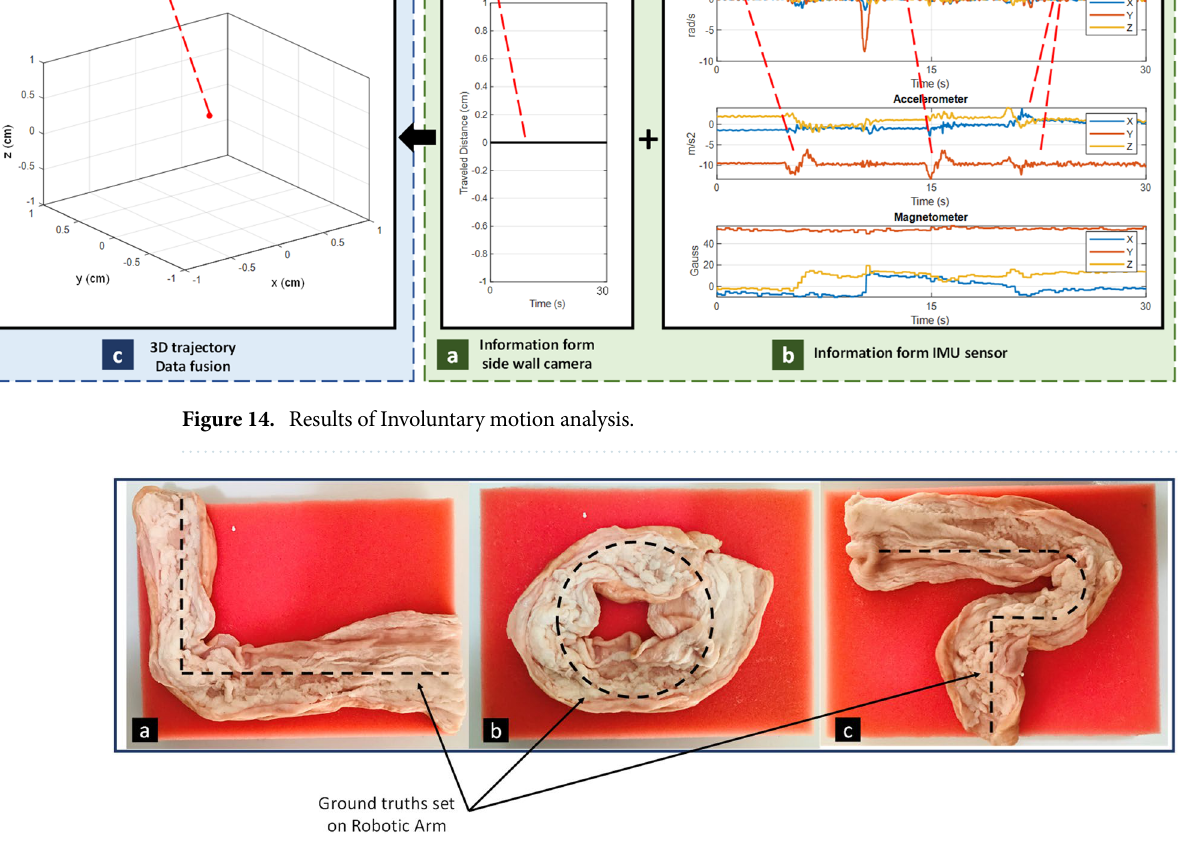
Figure 15. A piece of porcine intestine for test surface.